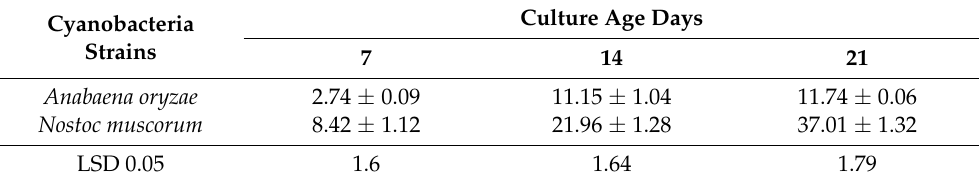
Table 1. The mean production of IAA from the tested cyanobacterial strains ( µ g/100 mL) ± standard deviation.